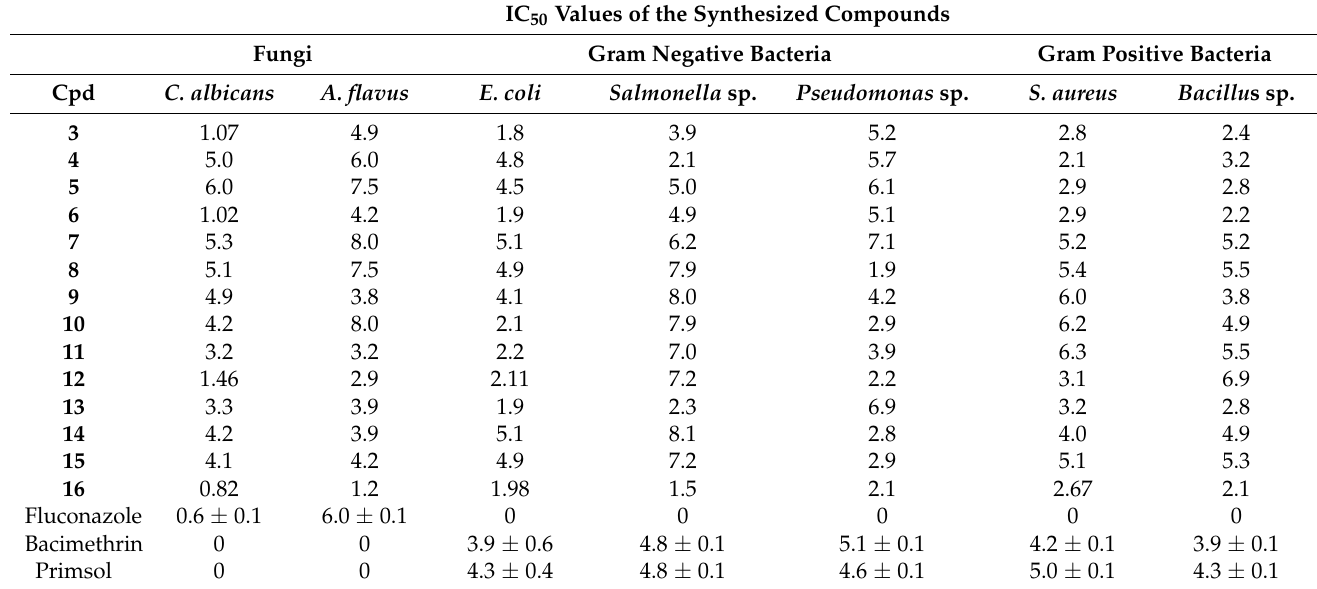
Table 2. IC 50 values of the tested compounds against the various multidrug resistance